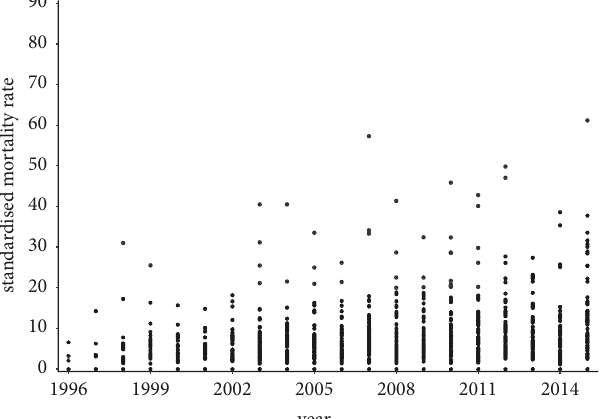
Figure 7: The standardised mortality rate of the individual districts of the Slovak Republic for the female sex throughout the whole period.